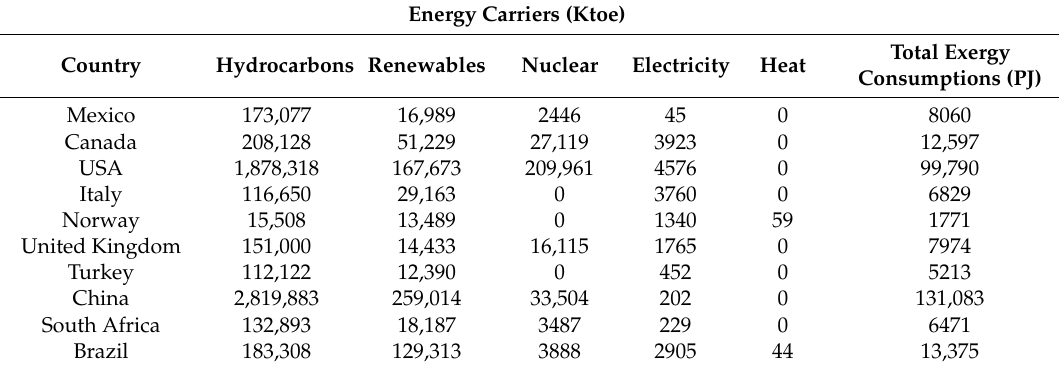
Table 3. Exergy consumption rates of countries, year